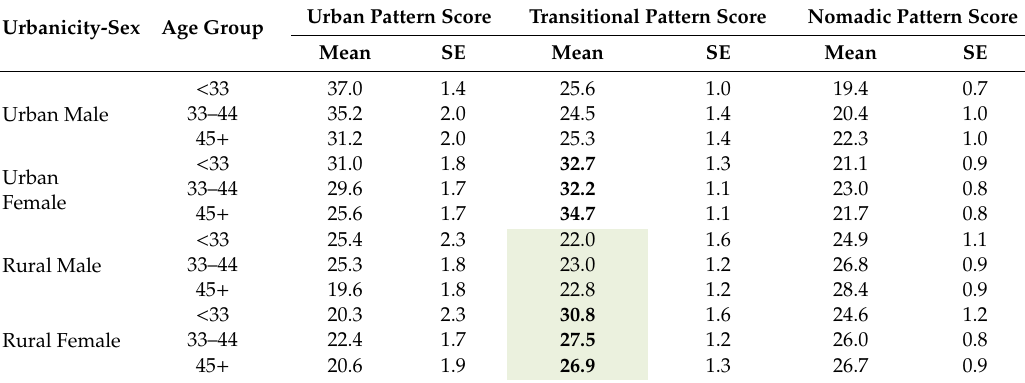
Table 8. Estimated marginal means of diet pattern scores by